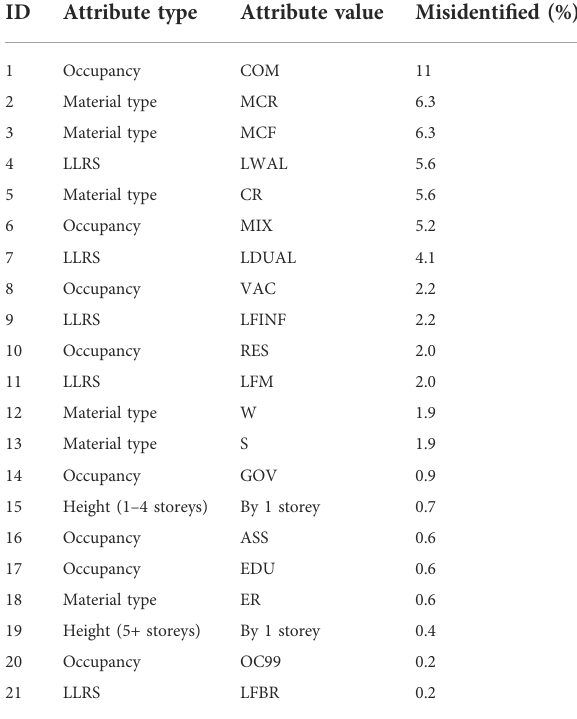
TABLE 2 Misidenti fi ed attribute values (disaggregated) in the remote